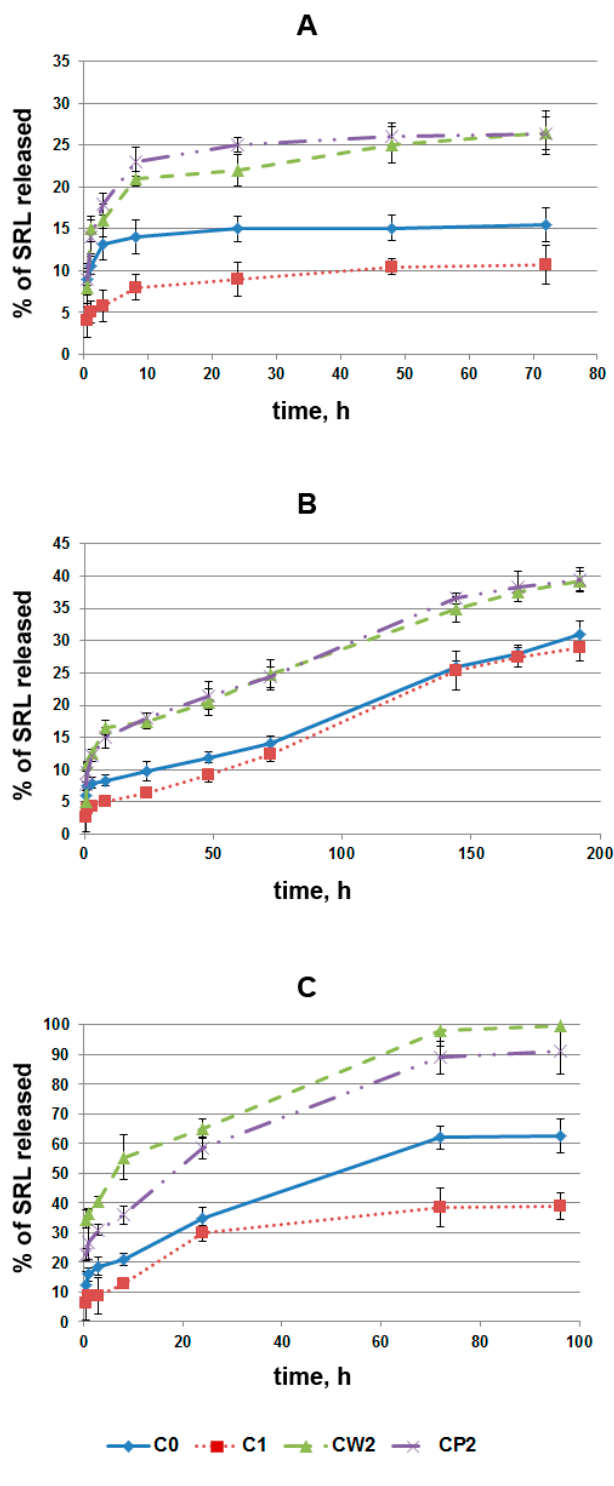
Figure 7. The kinetic curves of SRL release. ( А ) Adsorption and release in PBS; ( B ) adsorption in PBS and release in BP; ( C ) adsorption and release in BP. For adsorption of SRL, the initial mixtures of 1 mL, containing 100 µg of AC and 90 µg of SRL, were incubated for 48 h. Then, the supernatant was removed, and fresh PBS or BP was added. The amount of SRL adsorbed per 100 µg of AC in PBS was 76 ± 5, 83 ± 6, 69 ± 4.6, and 65 ± 4.5 µg for samples C0, C1, CW2, and CP2, respectively. Mean values for adsorption in BP were 6.5 ± 0.7, 15 ± 1.2, 3.6 ± 0.6, and 3.8 ± 0.5 µg per 100 µg of AC for samples C0, C1, CW2, and CP2, respectively.